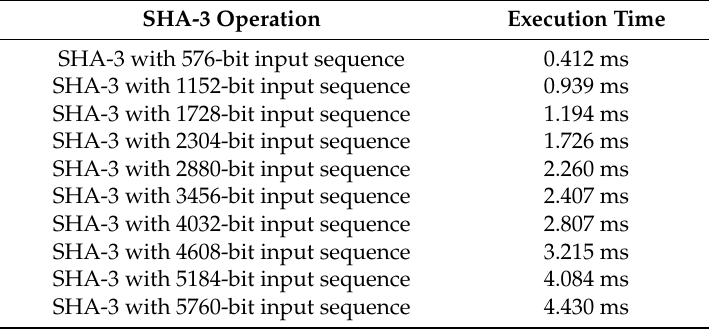
Table 6. The computation cost of SHA-3 with different length input sequences on Raspberry PI